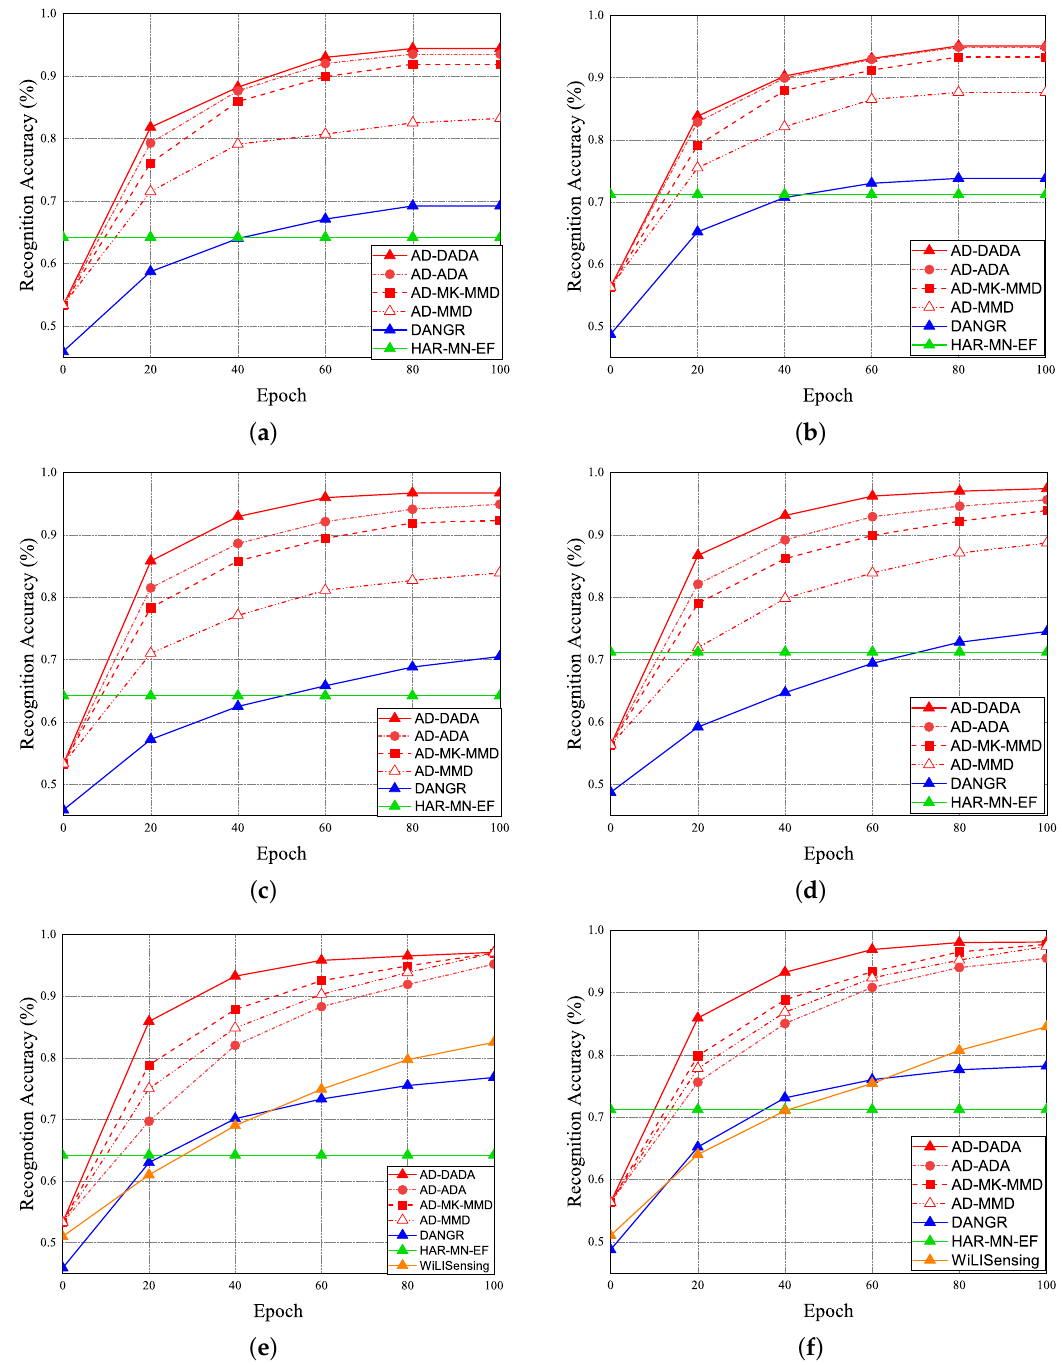
Figure 19. RA vs. epoch under ratios of labeled data = 0% and target data ratio = (1:1:1:1:1) for ( a ) target (A) and ( b ) target (B). RA vs. epoch under ratios of labeled data = 25% and target data ratio = (1:1:1:1:1) for ( c ) target (A) and ( d ) target (B). RA vs. epoch under ratios of labeled data = 100% and target data ratio = (1:1:1:1:1) for ( e ) target (A) and ( f ) target